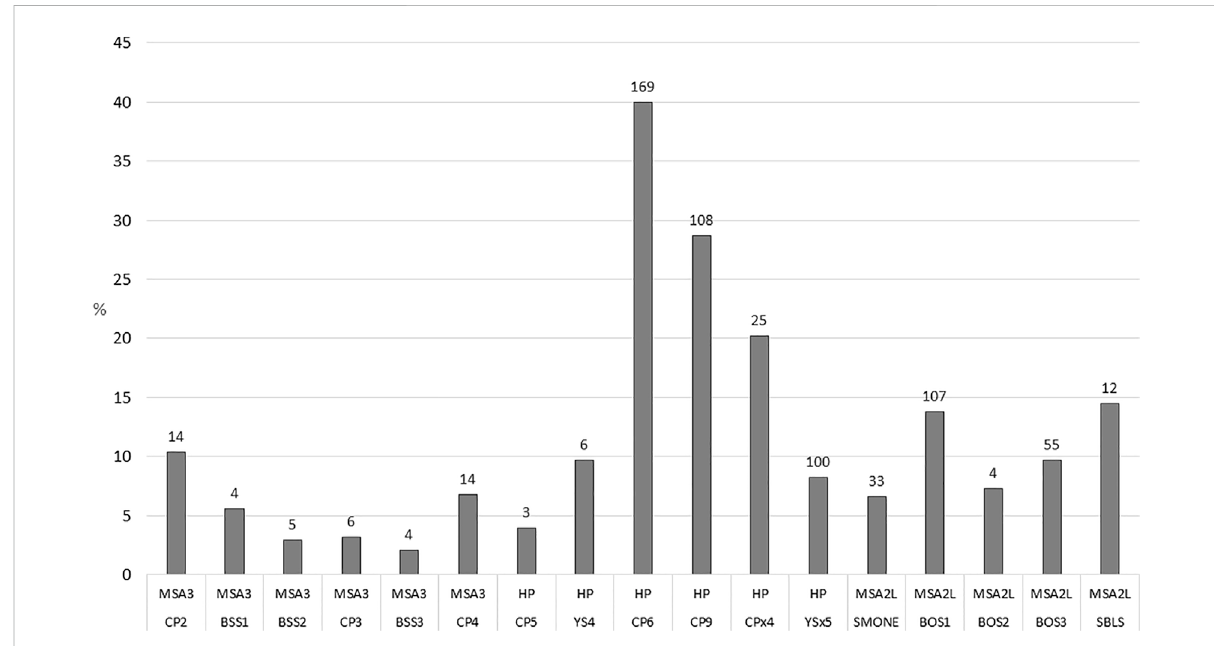
FIGURE 6 Frequencies oftrampledbone intheMSAIII, Howiesons Poort(HP) andMSA II Lower (L)phasesper layer atKlasiesRiver.Number ofspecimens above